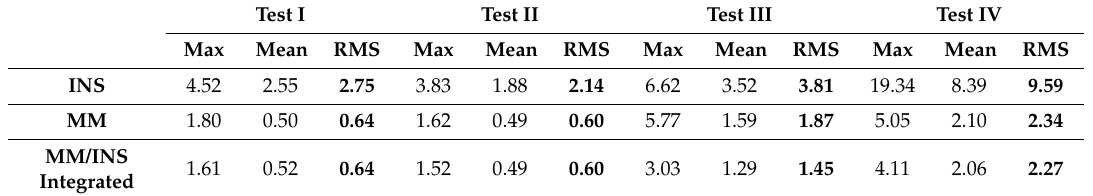
Table 1. Position errors of the INS, MM, MM/INS integrated methods for the four tests (units of m). Test